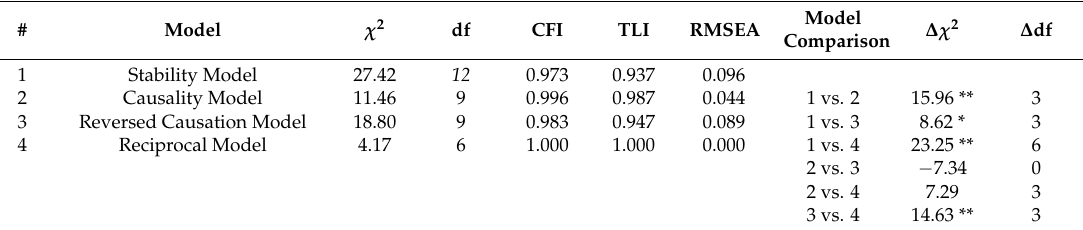
Table 2. Model comparison.